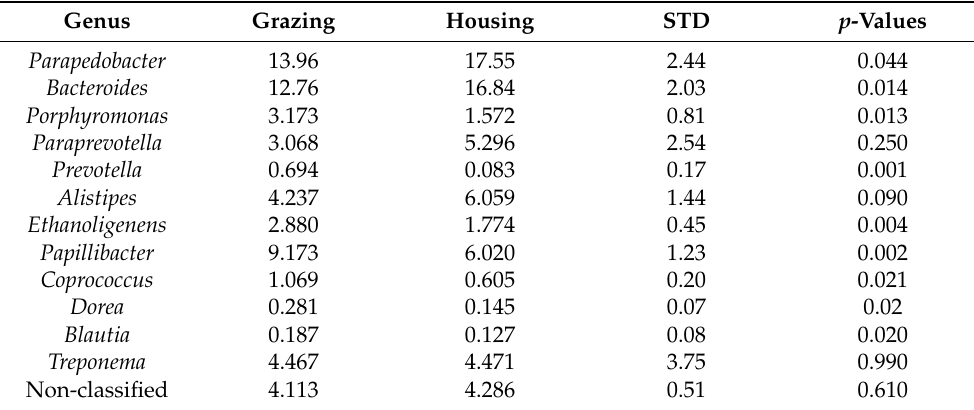
STD: Standard deviation. Table 3. Modulation of Pyrotages at the genus level in grazing and housing steer feces.